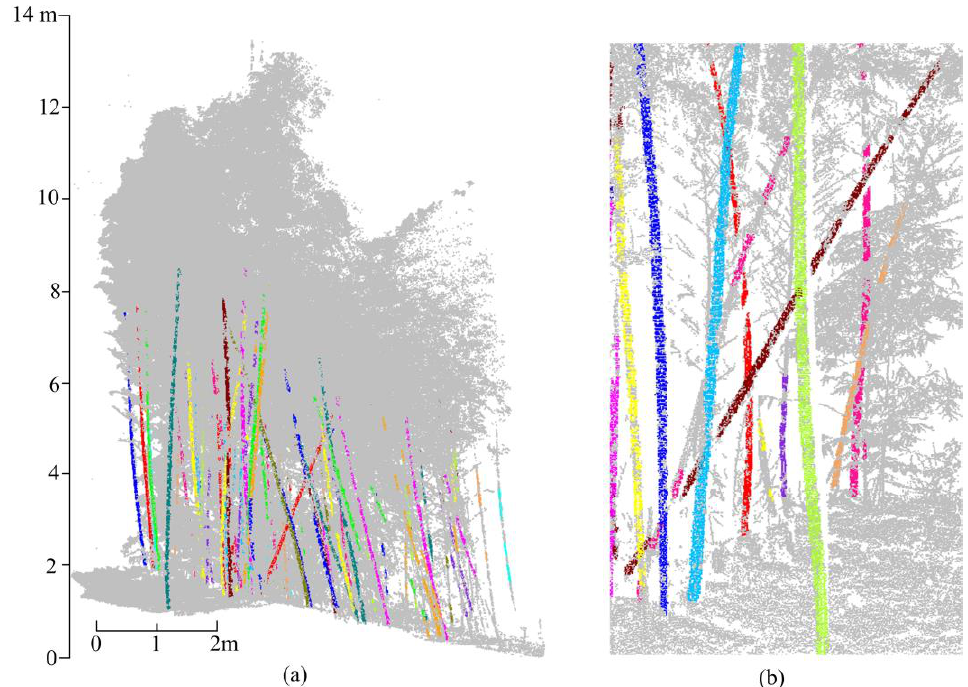
Figure 6. ( a ) Side view of Plot A: Bamboo on the hillside is inclined and stem clusters are fragmentized. ( b ) Details of Plot B: Stems are clumped and some are seriously